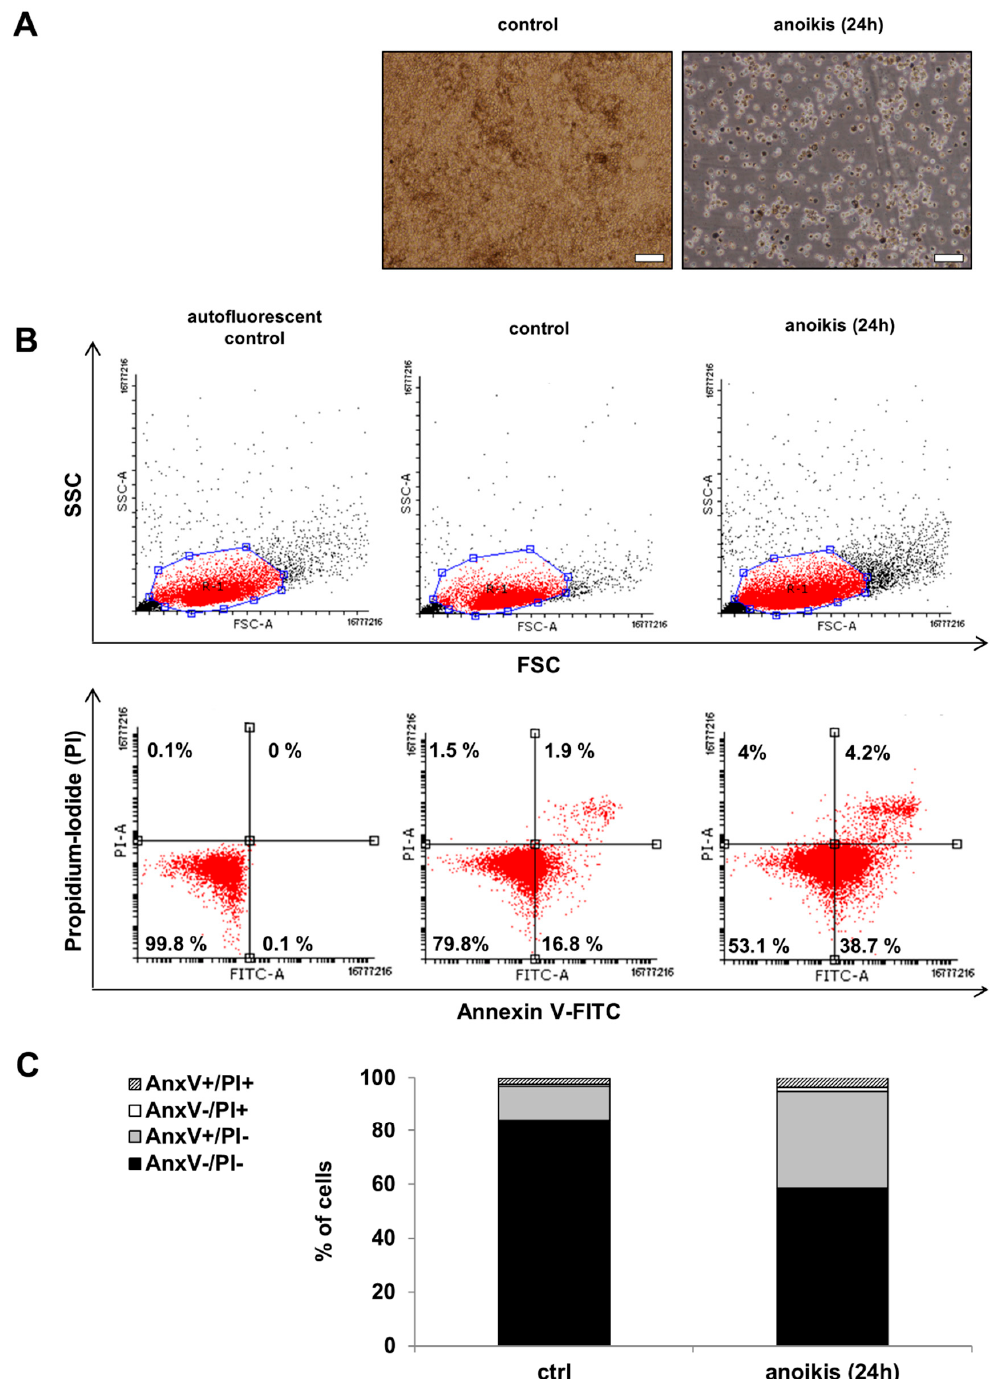
Figure 1. Morphological and cell death analysis after blocking the attachment of human embryonic stem cells-derived retinal pigment epithelium (hESC-RPE) cells to extracellular matrix (ECM). ( A ) Phase contrast images (10 × ) of untreated control hESC-RPE cells and anoikic hESC-RPE cells which were cultured on poly-2-hydroxyethylmethacrylate (poly-HEMA) coated culture dishes for 24 h to induce cell death by detachment from the extracellular matrix. Images were captured with a Nikon Eclipse TE2000-S phase contrast microscope. Scale bar indicates 20 µ m. ( B ) The induction of cell death by anoikis was determined by Annexin (Anx)V-FITC/PI double staining assay. Representative dot plots of AnxV/PI measurements of anoikic dying hESC-RPE cells are shown. Top: dot plots represent the measurements of forward light scattering (FSC; X axis) vs. side light scattering (SSC; Y axis). Bottom: the horizontal axis represents the intensity of staining for Annexin V (log scale) and the vertical